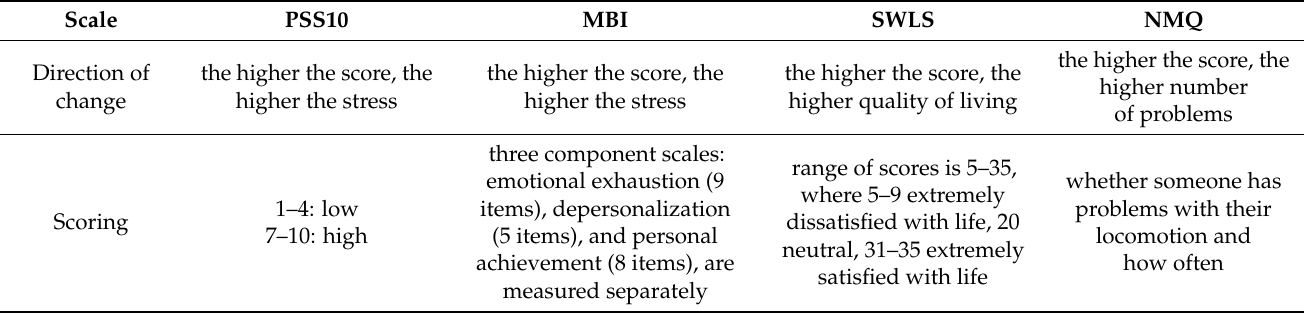
Table 2. Multivariate assessment used in the